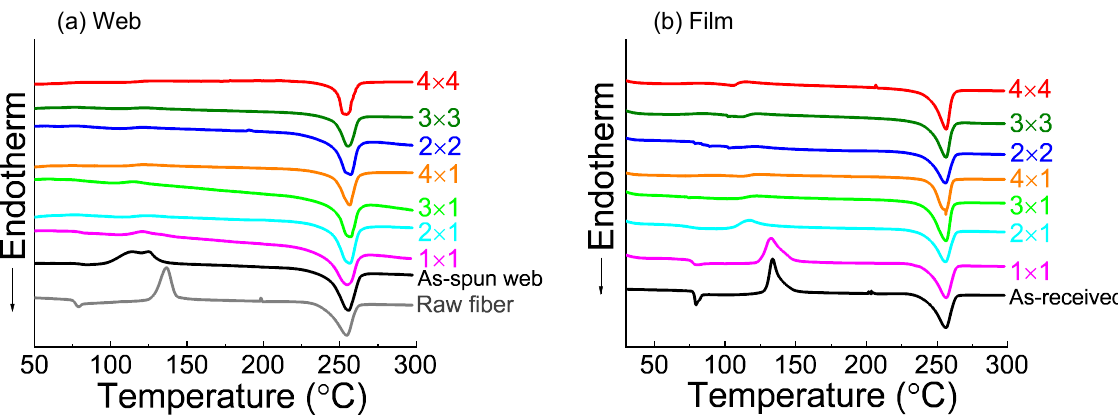
Figure 6. DSC thermograms of ( a ) web and ( b ) film samples of various processing conditions.